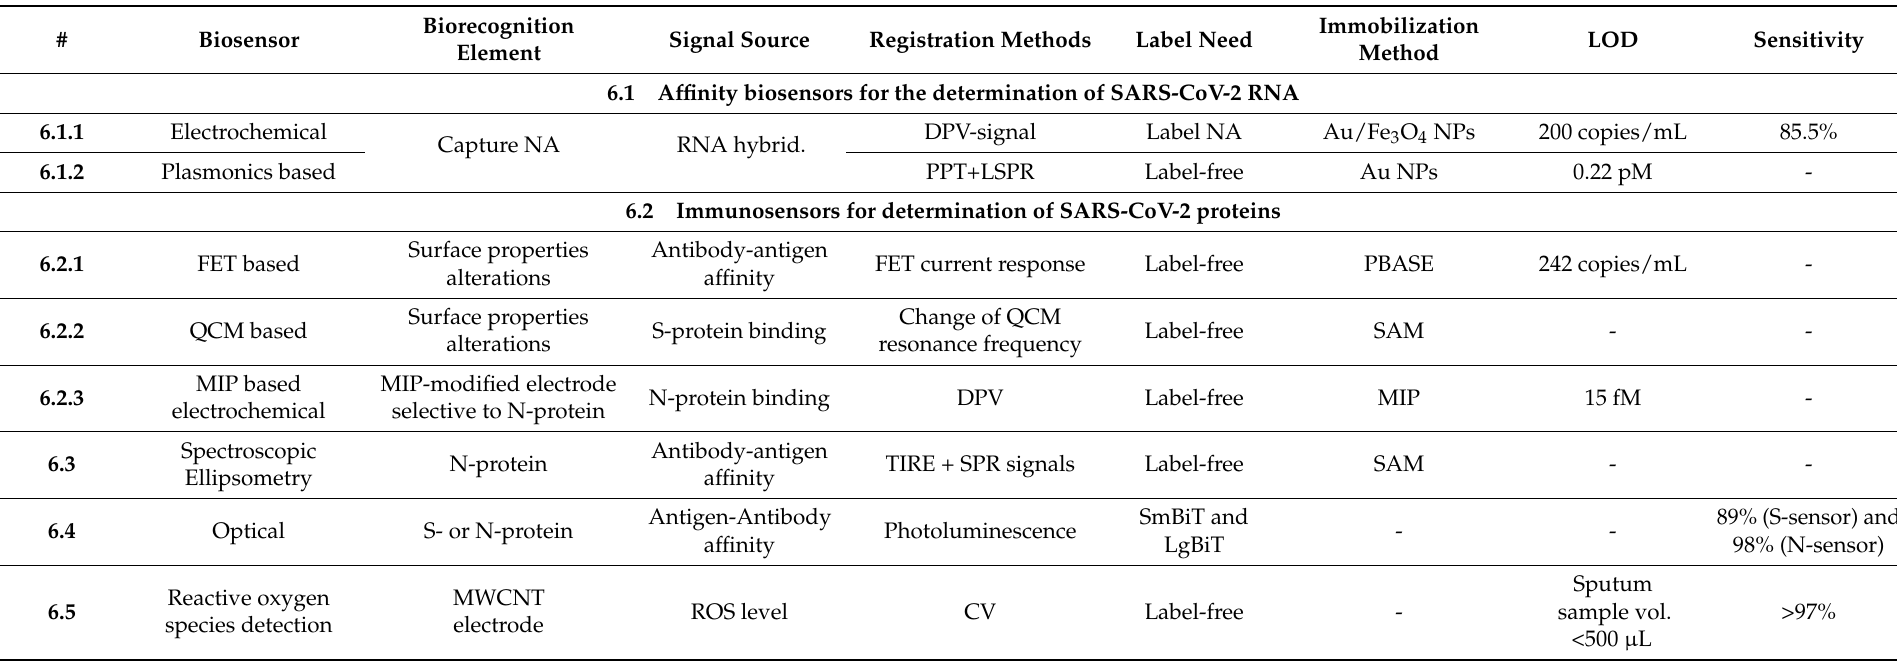
Table 2. Summary table of biosensors used for the diagnosis of